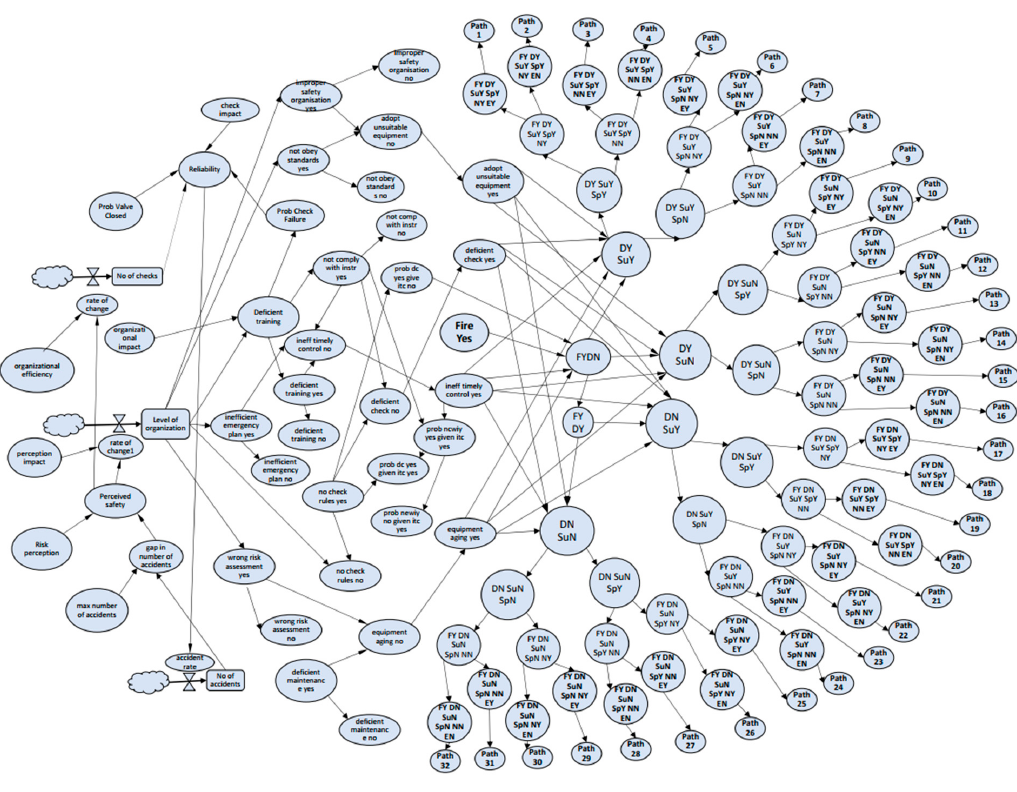
Figure A1. Visual representation of mapped SD model. Appl. Sci. 2020 , 10 , x FOR PEER REVIEW